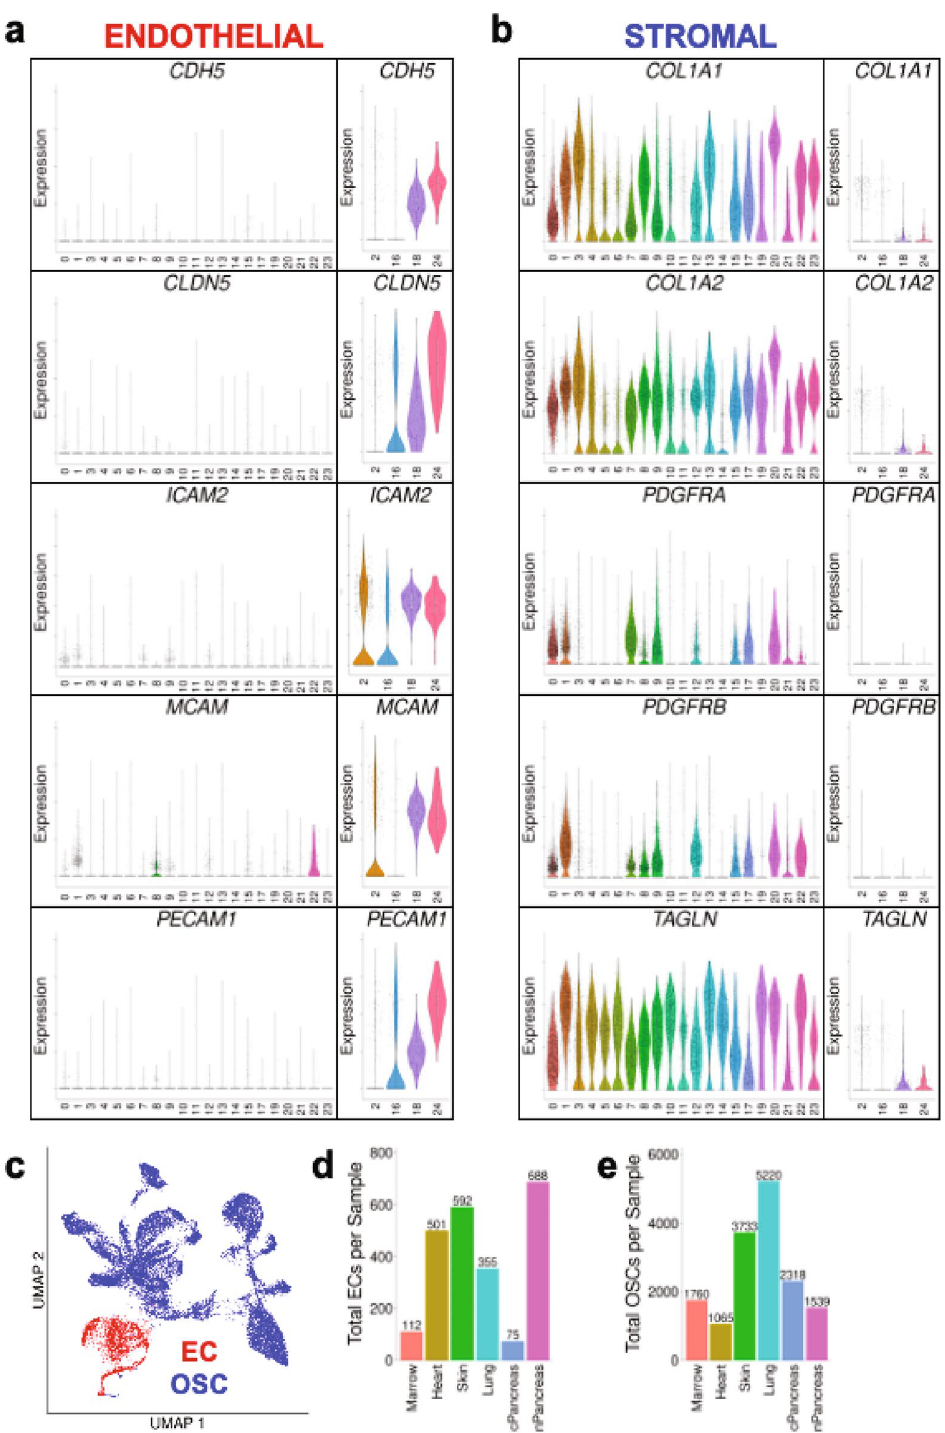
Figure 3. ECs and OSCs can be identified from 3D in vitro microvessel network dataset by expression of characteristic EC-specific and stroma-specific genes. ( a ) Violin plots of characteristic EC genes CDH5, CLDN5, ICAM2, MCAM, and PECAM1 for each cluster identified in complete 3D in vitro microvessel network dataset. ( b ) Violin plots of characteristic stromal cell genes COL1A1, COL1A2, PDGFRA, PDGFRB, and TAGLN for each cluster identified in complete 3D in vitro fibrin hydrogel dataset. ( c ) Overall UMAP plot for complete 3D in vitro microvessel network dataset broken down by EC/OSC classification (EC = red, OSC = blue). ( d ) Bar chart of resultant number of ECs per microvessel network type from the complete 3D in vitro microvessel network dataset. ( e ) Bar chart of resultant number of OSCs per microvessel network type from the complete 3D in vitro microvessel network